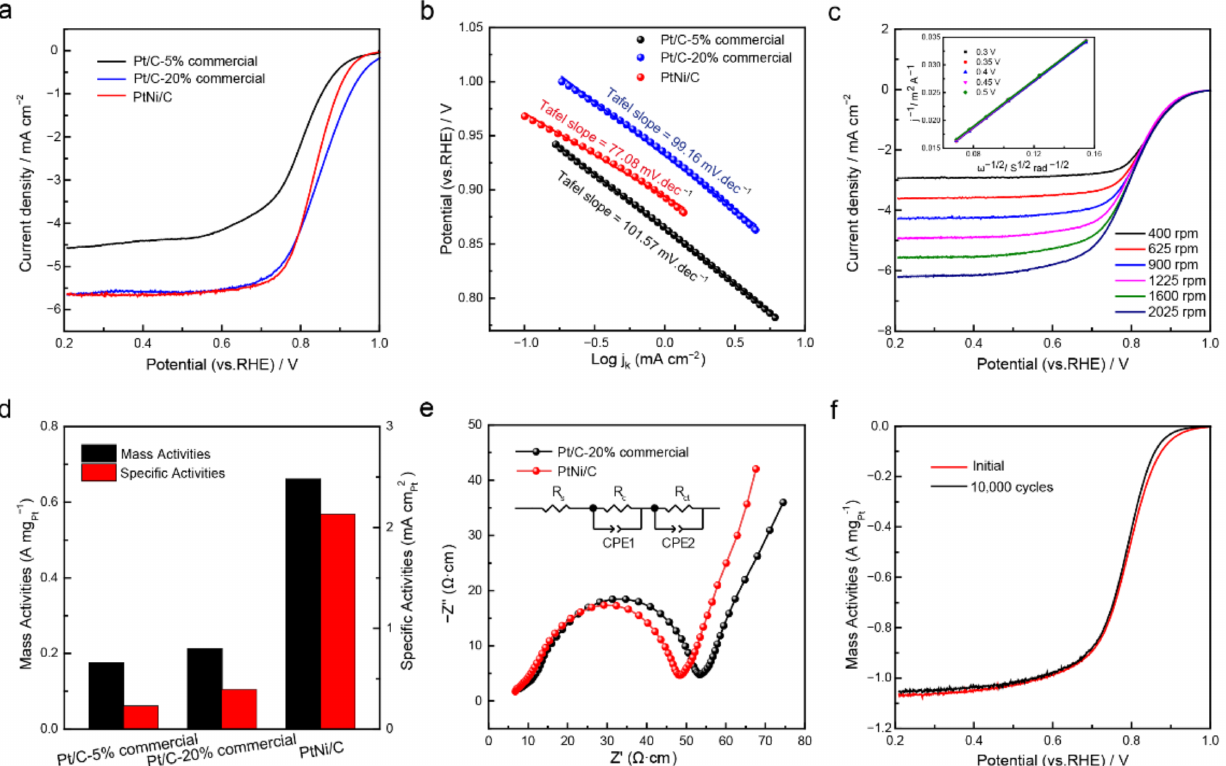
Figure 5. ORR performance of PtNi/C. ( a ) Polarization curves of PtNi/C, 5%, and 20% commercial Pt/C in 0.1 M KOH. ( b ) Tafel plots of PtNi/C, 5%, and 20% commercial Pt/C. ( c ) Polarization curves of PtNi/C at different rotating speeds: 400, 625, 900, 1225, 1600, and 2025 rpm (insert is the corresponding K-L analysis). ( d ) Mass activity and specific activity of PtNi/C, 5%, and 20% commercial Pt/C at 0.9 V (vs. RHE). ( e ) Deviation from the Randles circuit model and the corresponding EIS. ( f ) Polarization curves of PtNi/C measured before and after 10,000 cycles in 0.1 M